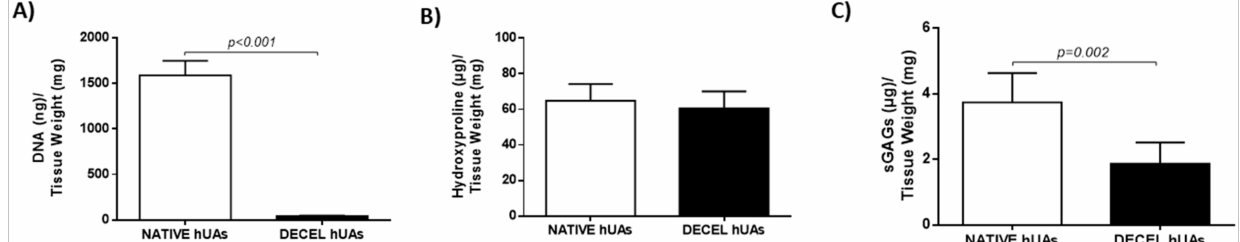
Figure 3. Biochemical analysis of hUAs. The biochemical analysis involved the DNA quantification ( A ), the hydroxyproline content ( B ) and sGAG content ( C ) quantification of native and decellularized hUAs. Statistically significant differences regarding the DNA ( p < 0.001) and sGAG ( p < 0.01) content were observed between native and decellularized